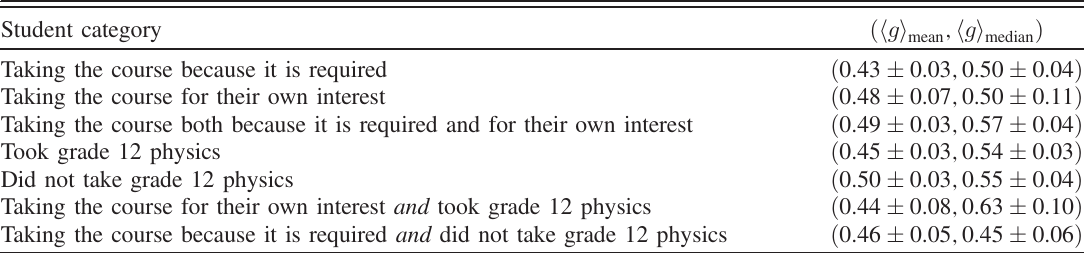
TABLE V. Average and median normalized gains for various student categories. Student